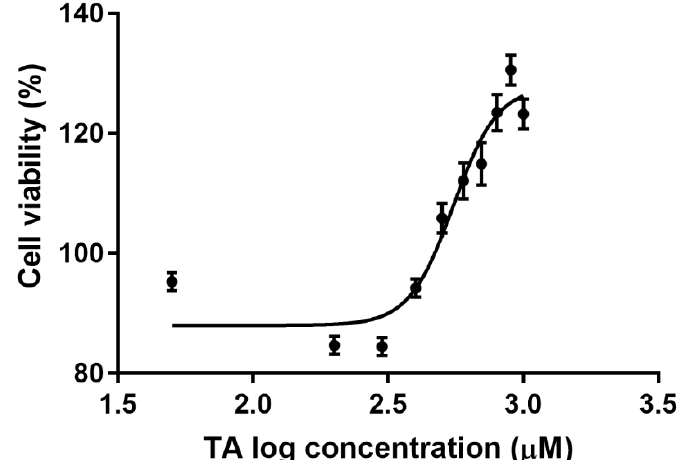
Figure 1. The e ff ect of tannic acid (TA) on Hek-293 cell viability. TA induced a characteristic increase in